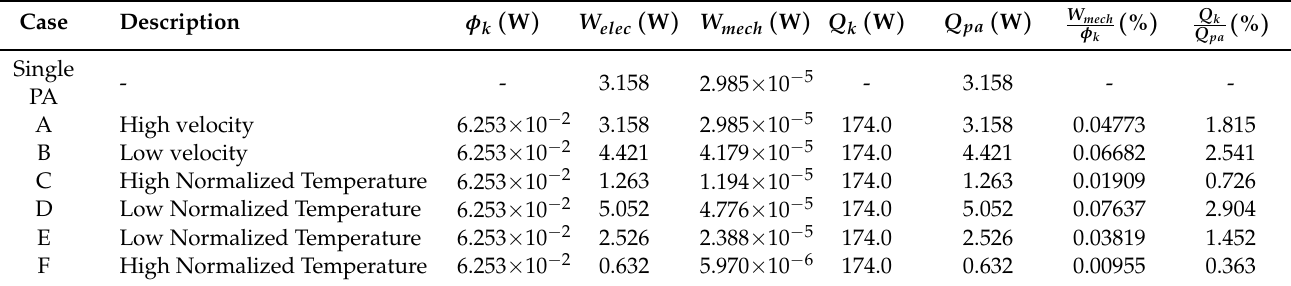
Table 3. Power analysis for all cases.